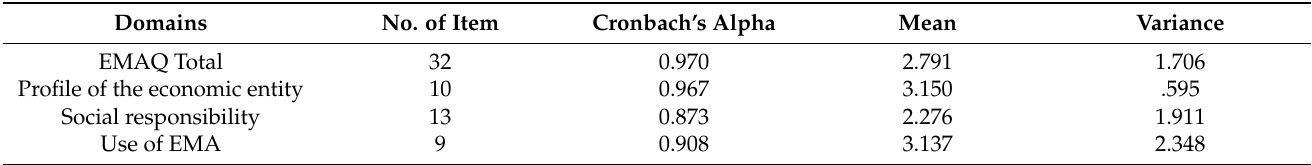
Table 2. Descriptive analysis of the viability